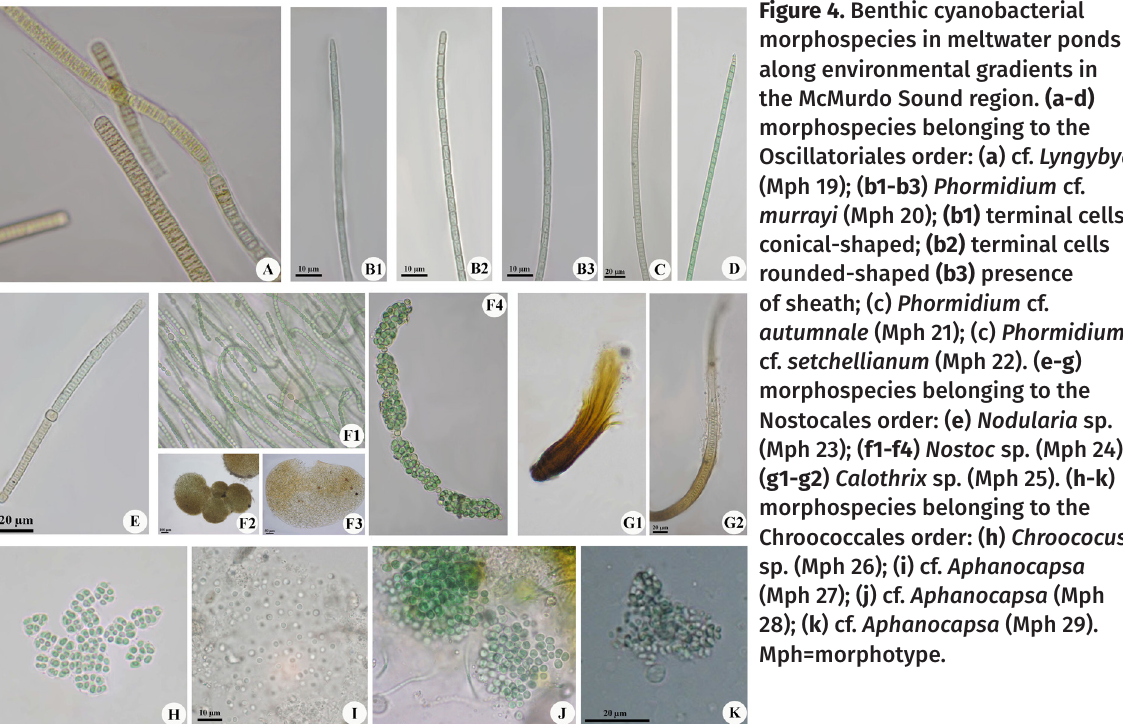
Morphotype 7 (Fig. 2g1-g4) Description : Filamentous trichome, straight